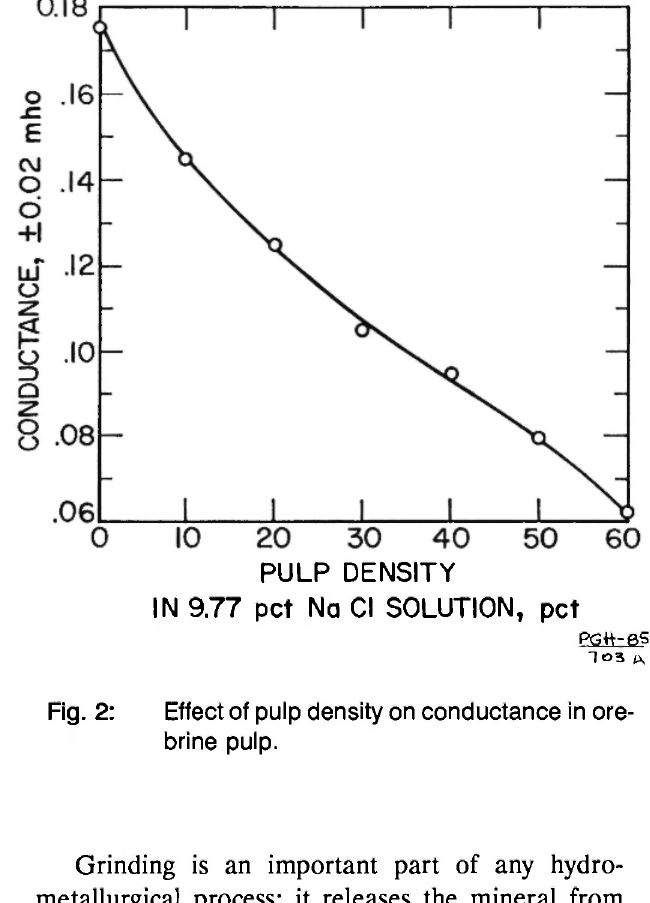
Fig. 2: Effect of pulp density on conductance in ore- brine pulp.